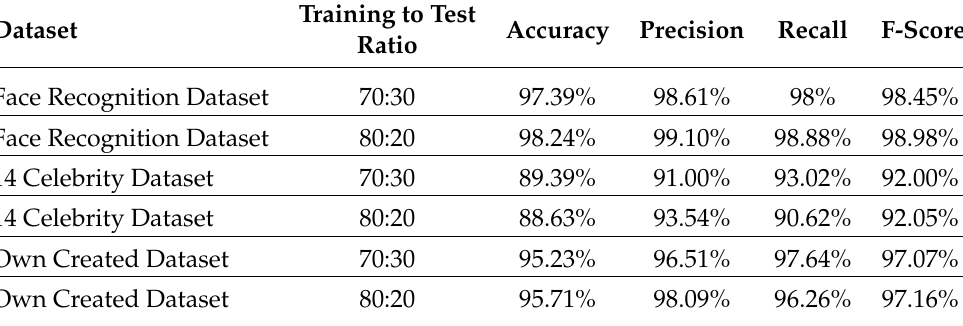
Table 6. Experimental Results of the proposed methods on Standard Image